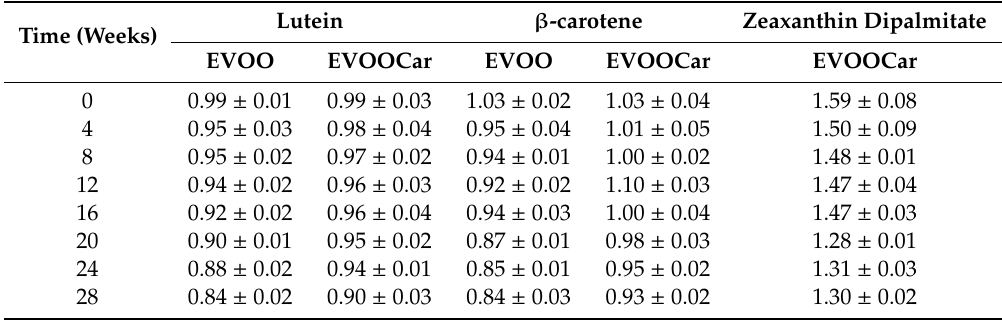
Table 1. Content (mg / 100 mL, mean values ± standard deviation, n = 3) of lutein, β -carotene, and zeaxanthin dipalmitate in EVOO and EVOOCar during